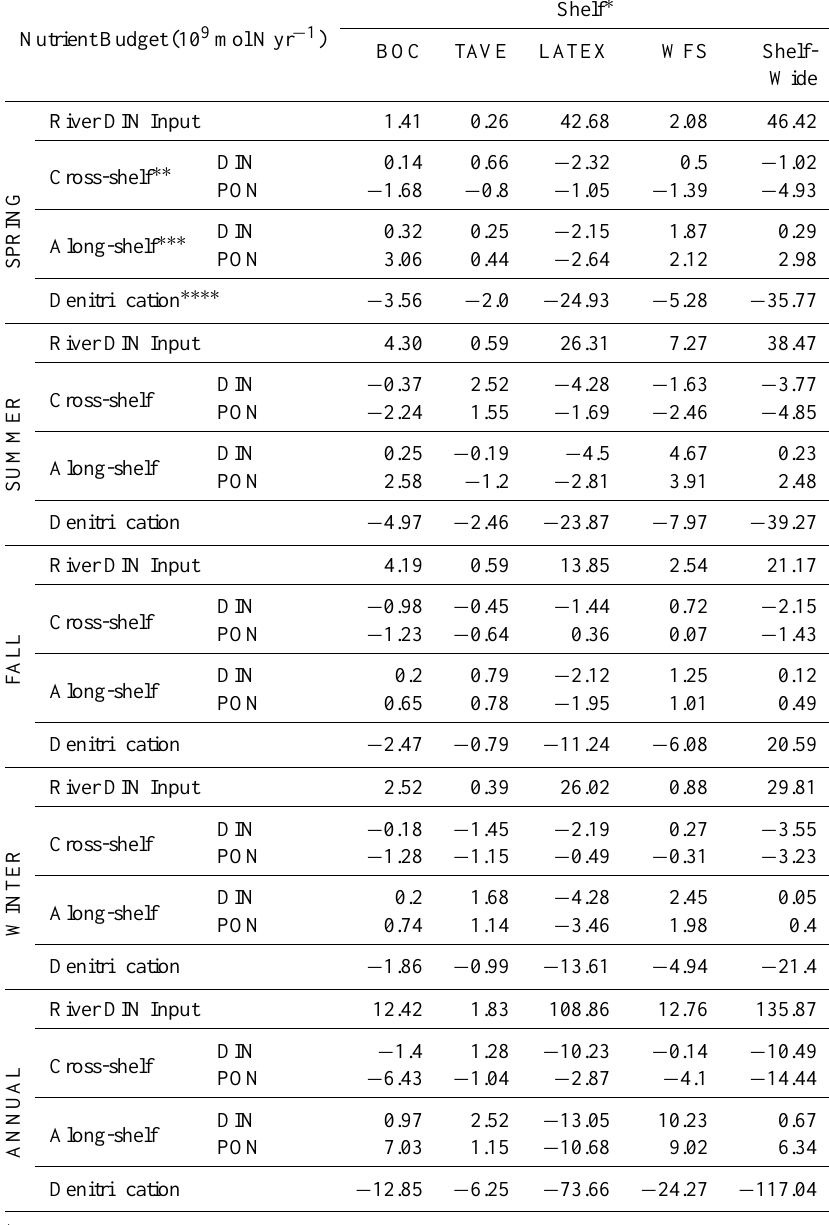
Table 2. River, cross-shelf (at 50m isobath), along-shelf, and denitrification budget in the inner shelf.